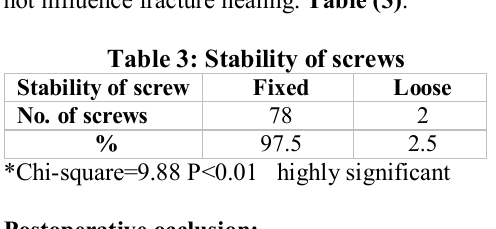
Table 6: Complications related to